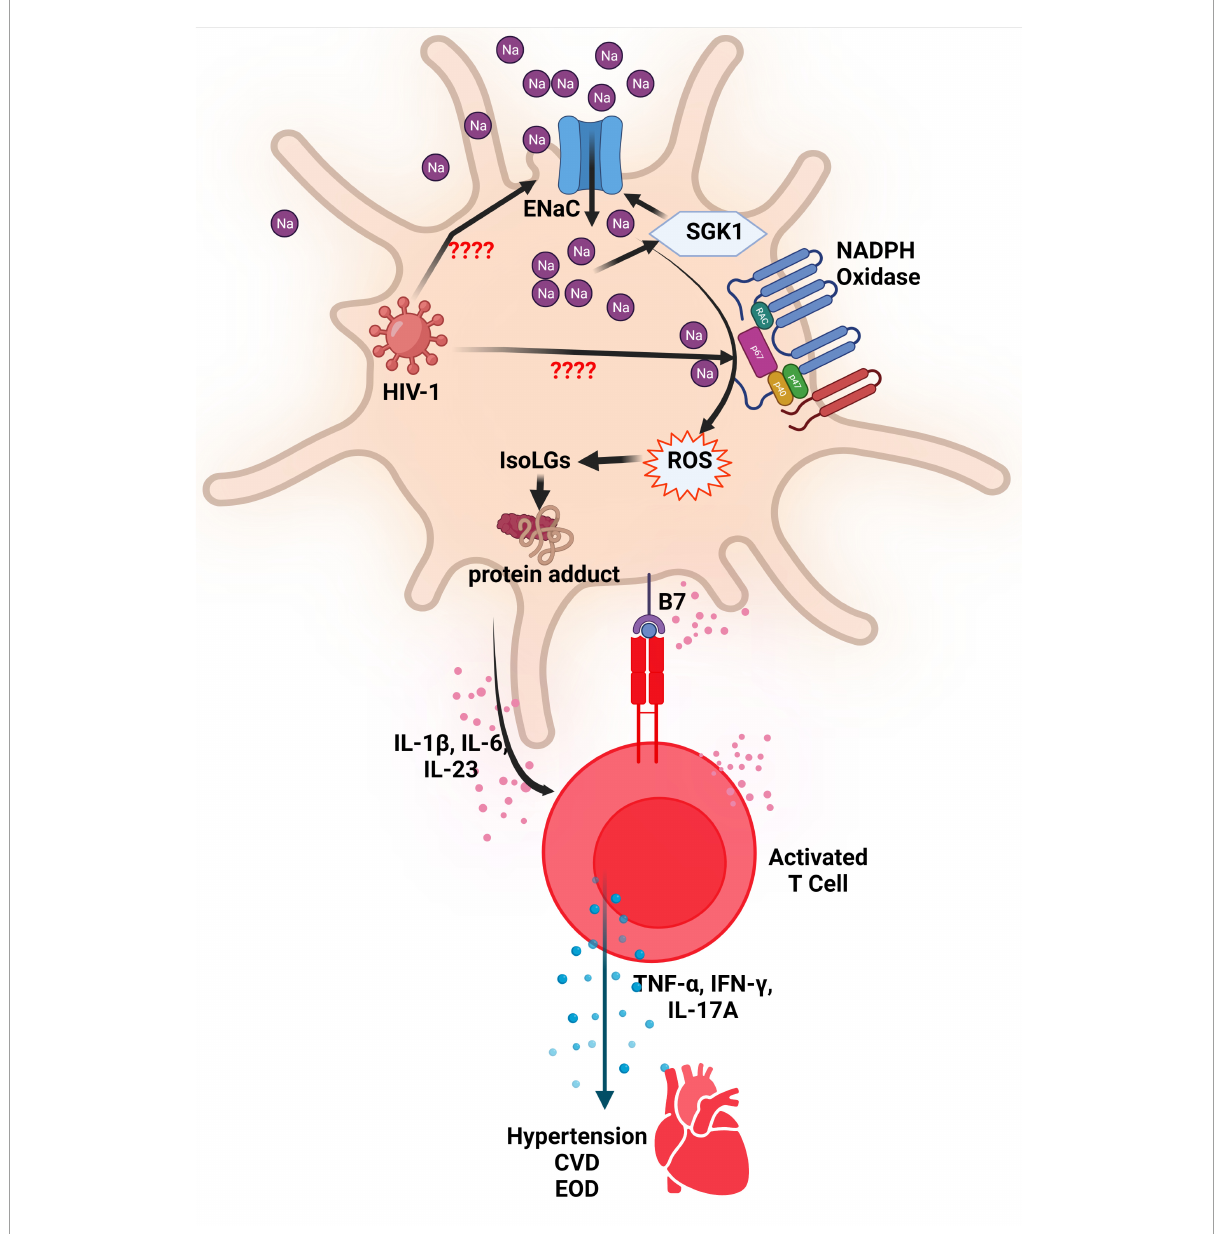
FIGURE2 ENaC and NADPH oxidase activation in DCs resulting in hypertension. The increased activity of the endothelial sodium channel (ENaC) leads to an increase in Na+ ions that activates the enzyme NADPH Oxidase. The increased activity of NADPH Oxidase results in production of reactive oxygen species (ROS) which leads to formation of Isolevuglandins (IsoLGs). IsoLGs adduct to intracellular proteins and become neoantigens that are presented to T cells to activate them. Activated T cells produce inflammatory cytokines that contribute to development or progression of hypertension, cardiovascular disease (CVD) and end organ damage (EOD). It is thought that HIV-1 activates ENaC and NADPH in antigen presenting cells resulting in similar effects. SGK1, serum-and-glucocorticoid-induced kinase; NADPH, Reduced nicotinamide adenine dinucleotide phosphate; Na, sodium; HIV-1, human immunodeficiency virus type 1; IL, interleukin; TNF- α , tumor necrosis factor alpha; IFN- γ , interferon gamma; CVD, cardiovascular disease; EOD, end organ damage.